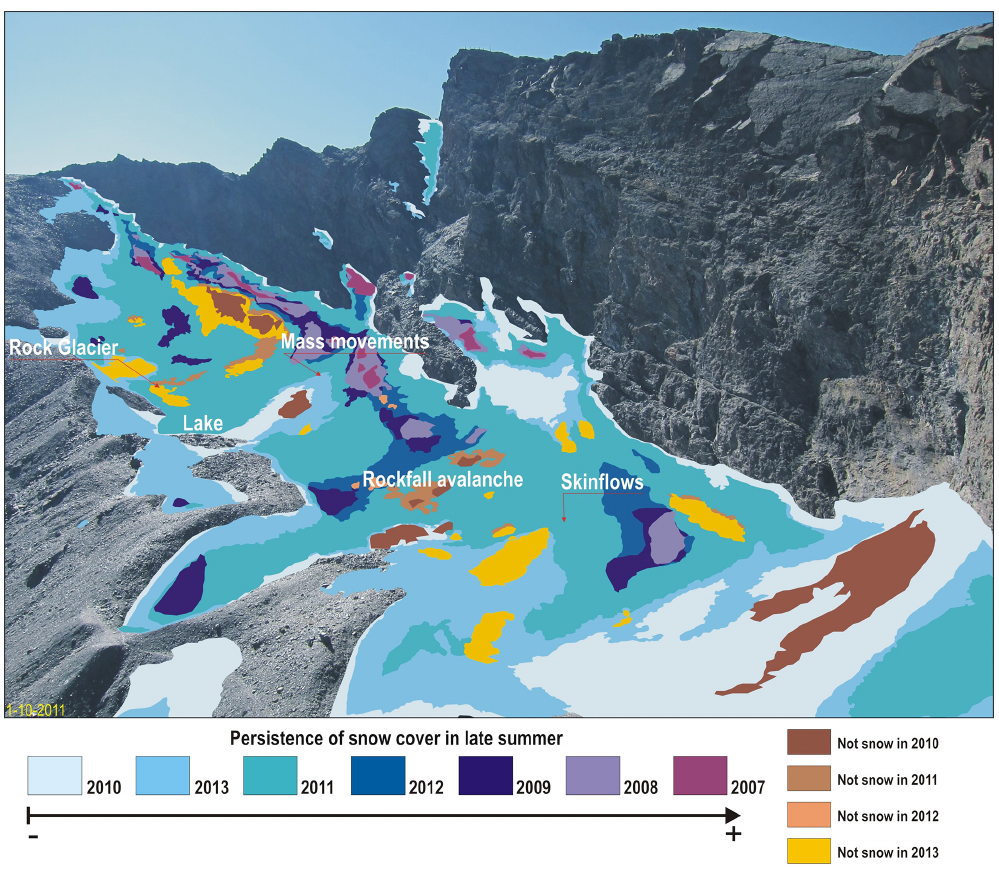
Figure 7. Evolution of snow cover on the Corral del Veleta for